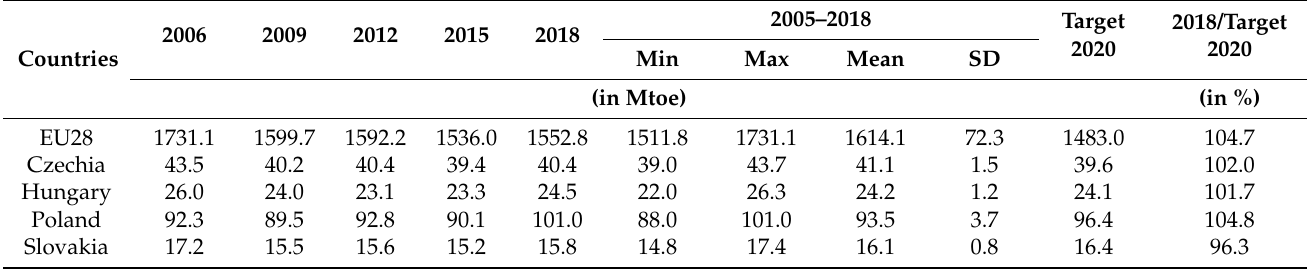
Table 6. Primary energy consumption in V4 countries in the years 2006–2018.